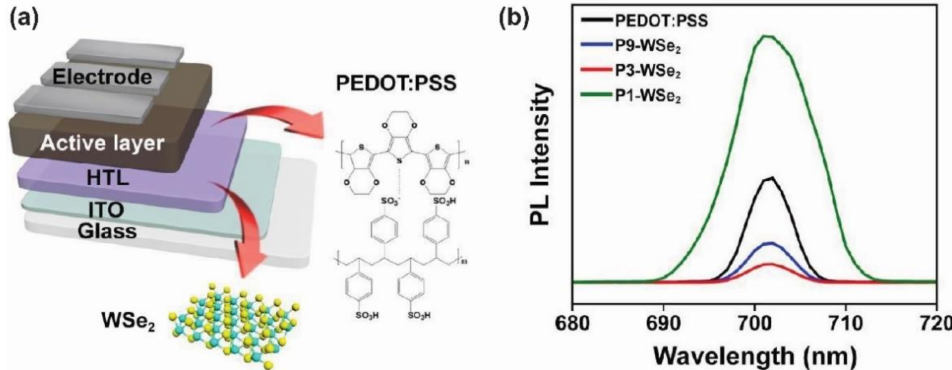
Figure 18. ( a ) Schematic representation of a WSe 2 -PEDOT:PSS HTL-based OSC and ( b ) PL spectra measured from structure of glass/PEDOT:PSS and P-WSe 2 -based devices. Adapted with permission from [333]. Copyright 2018, IOP Publishing